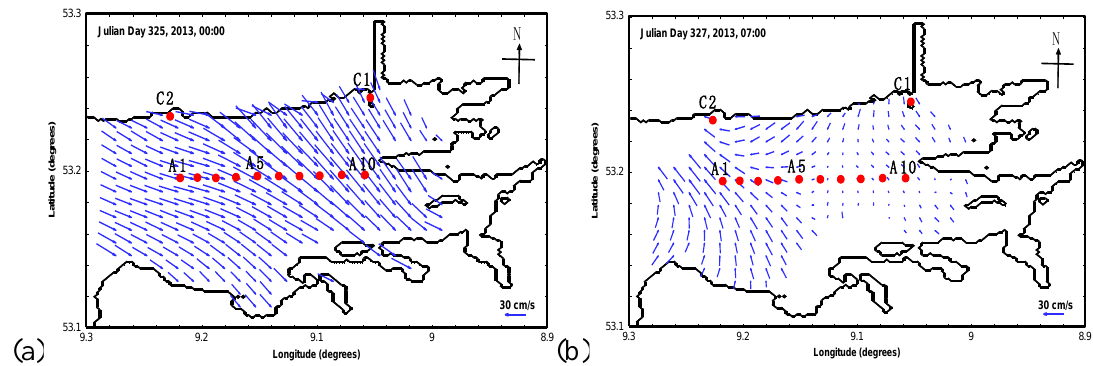
Figure 1. Deployment of CODAR system and surface flow fields of radar data: ( a ) snapshot of surface flow field at Julian Day 325, 2013, 00:00; and ( b ) snapshot of surface flow field at Julian Day 327, 2013, 07:00. A1–A10 indicate ten analysis locations and C1 and C2 denote radar stations.